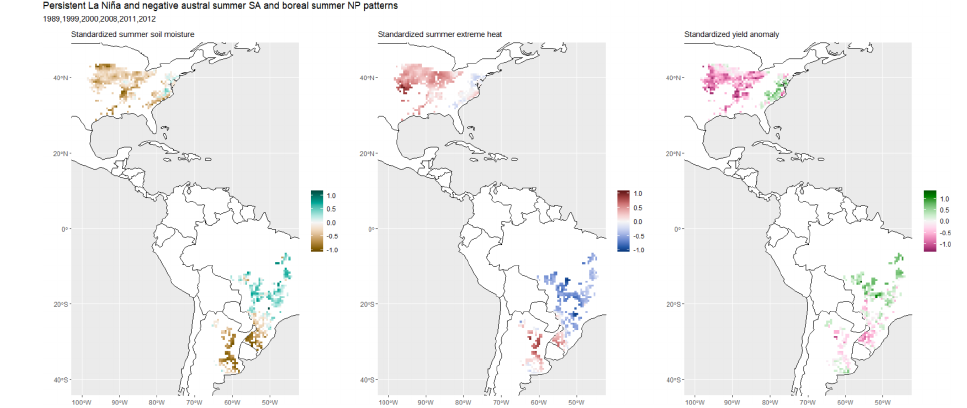
Figure A6. Similar to Fig. A5, but the subset additionally filters for years when both the Southern Hemisphere summer SA pattern & Northern Hemisphere summer NP pattern are negative.